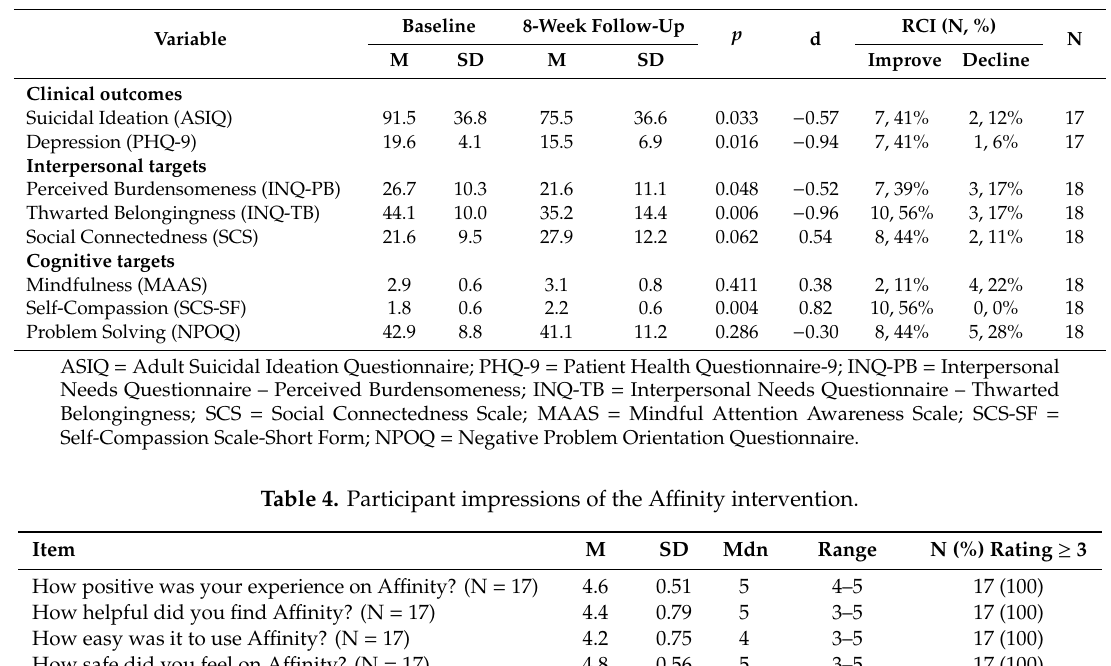
Table 3. Means (M), standard deviations (S.D.), and within-group e ff ect sizes (Cohen’s d) for therapeutic targets and clinical outcomes.